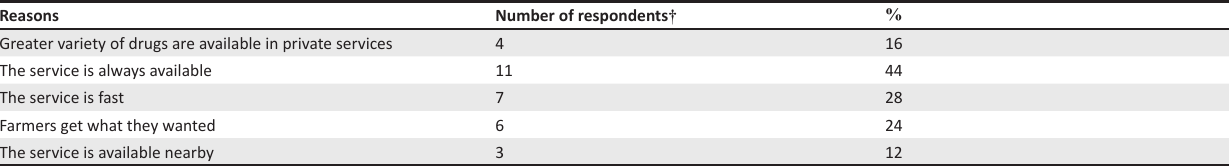
TABLE 4: Reasons indicated by farmers for preference of private service.